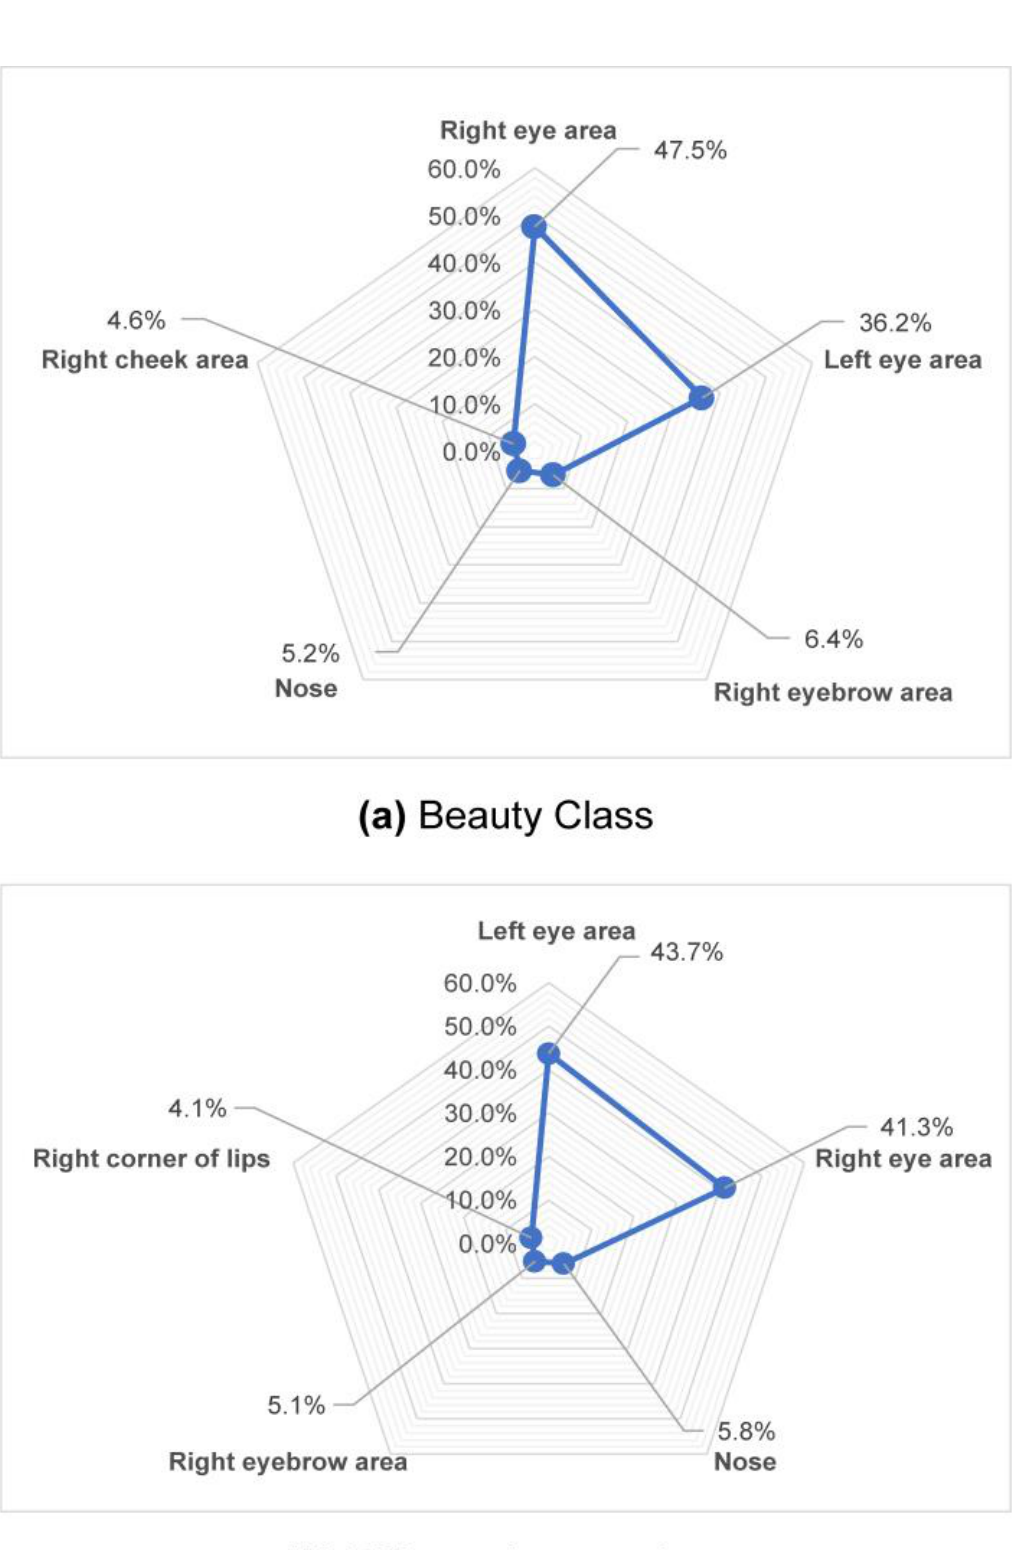
Figure 7. Most Dependent Feature ( MVF ). ( a ) Shows the Top-5 features the machine was depending on when making Beauty class decision. ( b ) Shows the Top-5 features the machine was depending on when making Different beauty class decision.